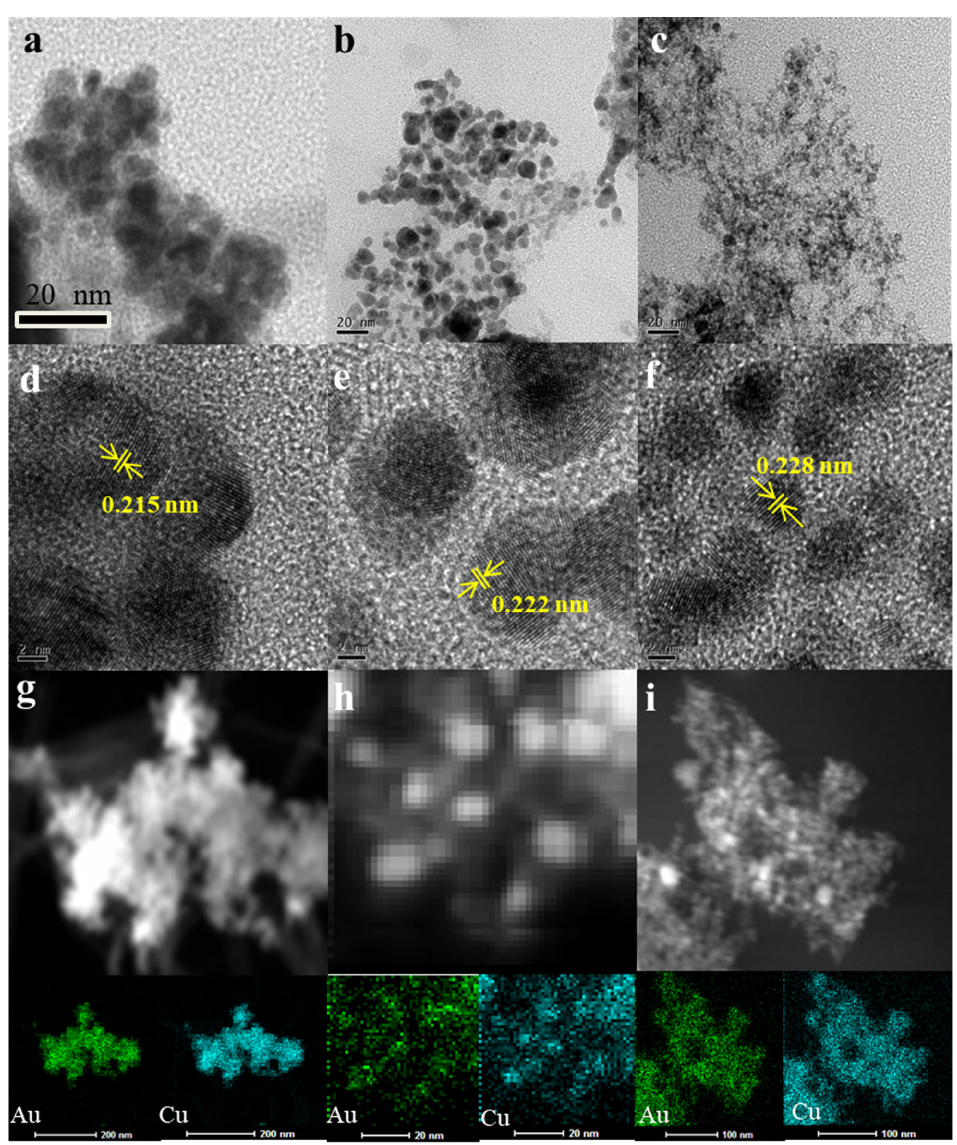
Figure 1. TEM and HR-TEM images of the Au n Cu 100 − n NPs samples. Au 25 Cu 75 ( a , d ), Au 50 Cu 50 ( b , e ) and Au 75 Cu 25 ( c , f ) with lattice fringes and corresponding facets indicated. EDS element mappings of Au 25 Cu 75 ( g ), Au 50 Cu 50 ( h ) and Au 75 Cu 25 ( i ).